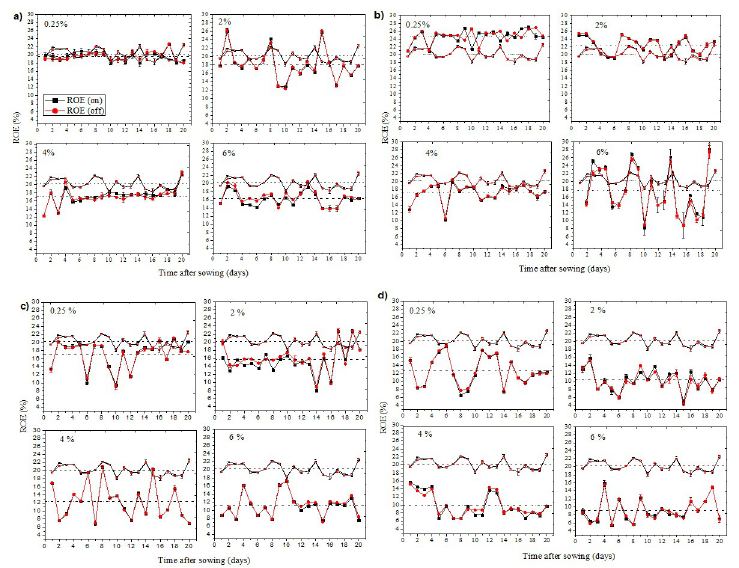
in Table 1. In this Figure, the black squares and the red circles correspond to experimental points of ROE measured when the photosynthesis of the plant was saturated (continuous white light on) and after it was restored (continuous white light off), respectively; the empty dots of these same shapes and colors correspond to experimental points from measurements of the control group plants.